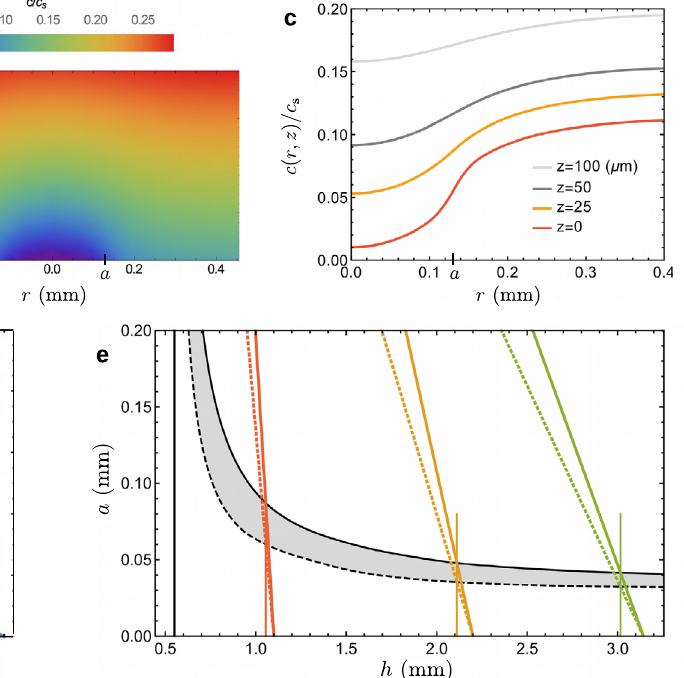
Fig. 3 | A simple model captures the domain size. a In the geometry considered, solving Eq. (2). The continuous and dashed lines correspond to surface fraction : 16 ϕ ϕ ) predicted when ϕ = ϕ theaggregateandbackgroundhave,respectively,radius a and b ,andcelldensity ρ a max and 0 max , respectively. e Aggregate size a ( h , and ρ b , while the mean cell density (cid:1) ρ is fi xed. The aggregate surface fraction is accountingforthethicknessdependenceofmeancelldensity (cid:1) ρ .Theblacklinesare (cid:1) ρ = ρ ϕ ≡ a 2 / b 2 , with maximal value ϕ fi eld c ( r , z ) solutions of Eq. (4). Graphically, they correspond to the intersection between the max = a . b , c Oxygen concentration colored oblique lines, reproduced from panel ( d ), and the vertical line at a fi lm around an aggregate. Here (cid:1) ρ =10 6 cm − 2 , h =1mm, ϕ =0 : 16 ϕ max and the size height h solution of (cid:1) ρ exp ð h Þ = (cid:1) ρ . As above, ϕ = ϕ max and 0 : 16 ϕ max for solid and domain is a =130 μ m. The minimal concentration, reached at the origin, is the dashed lines, respectively. The shaded area shows the aggregate size expected in target concentration ^ c , i.e., c ð 0,0 Þ = c s = ^ c = c s =0 : 01. d Aggregate size a ð (cid:1) ρ , h , ϕ Þ pre- dicted when (cid:1) ρ and h are independent parameters, obtained from numerically